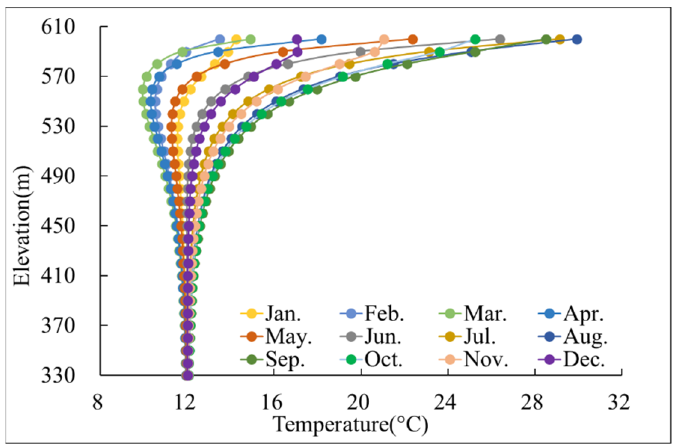
Figure 13. Measured reservoir water temperature.